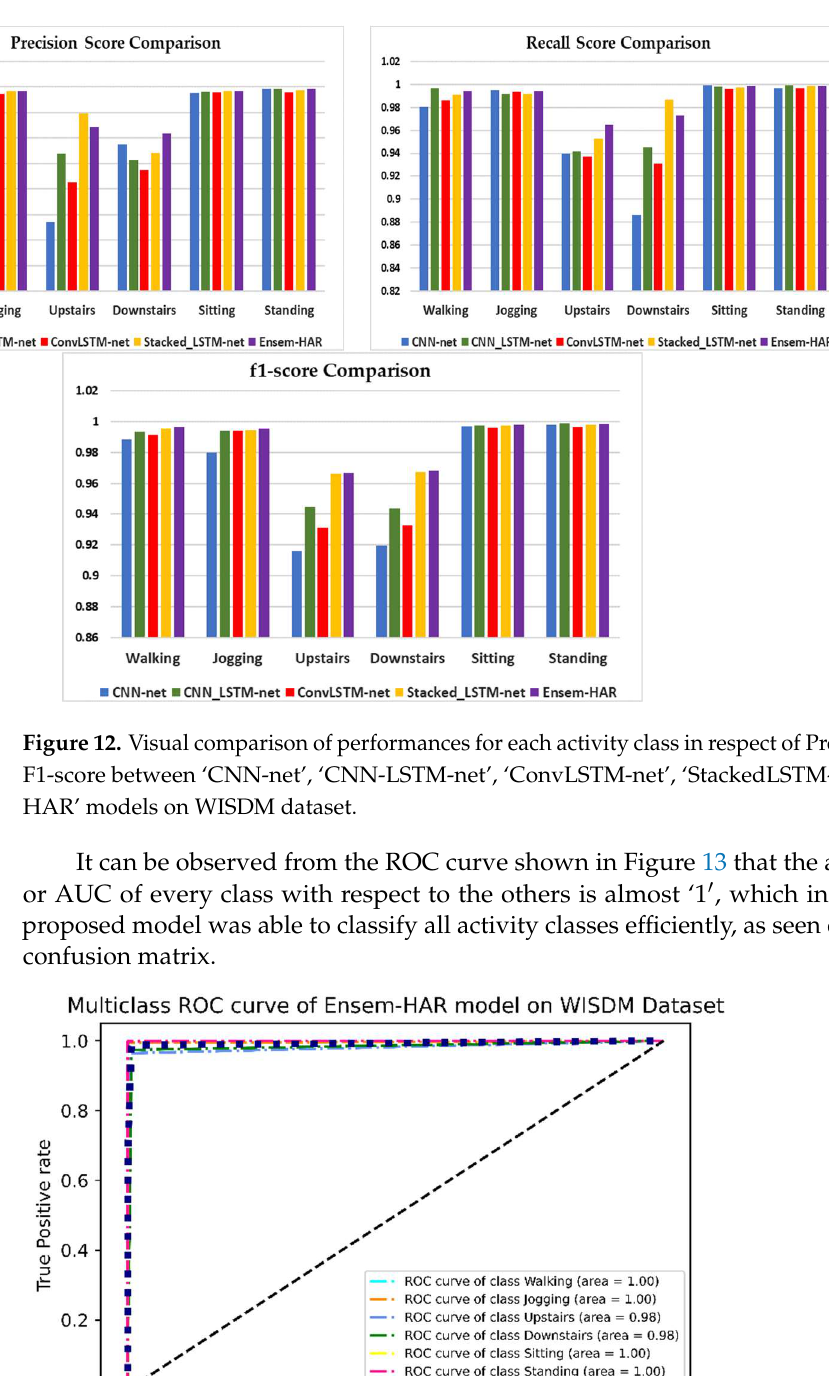
Figure 11. Accuracy (in %) comparison between four base models and Ensem-HAR model on the WISDM dataset.